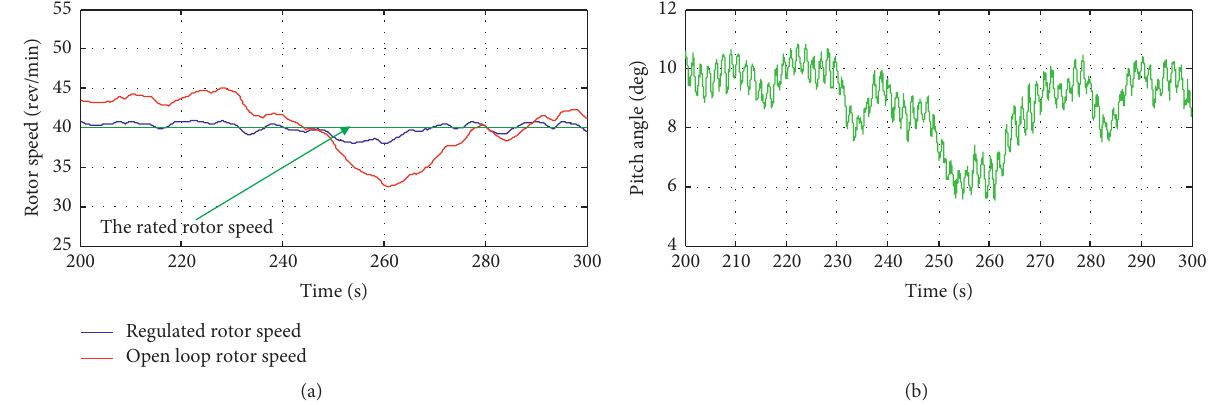
Figure 10: Zoom on the rotor speed (rpm) and the blade pitch angles (degrees) in the region [200, 300] sec.